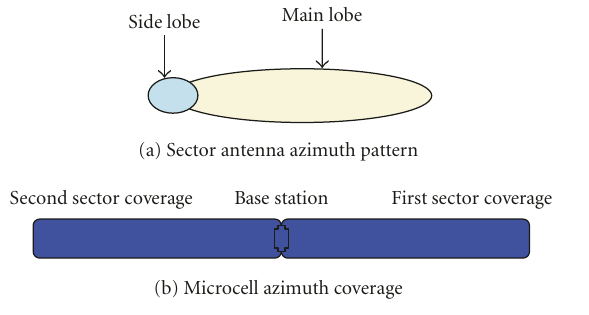
Figure 1: The sector and microcell coverage.